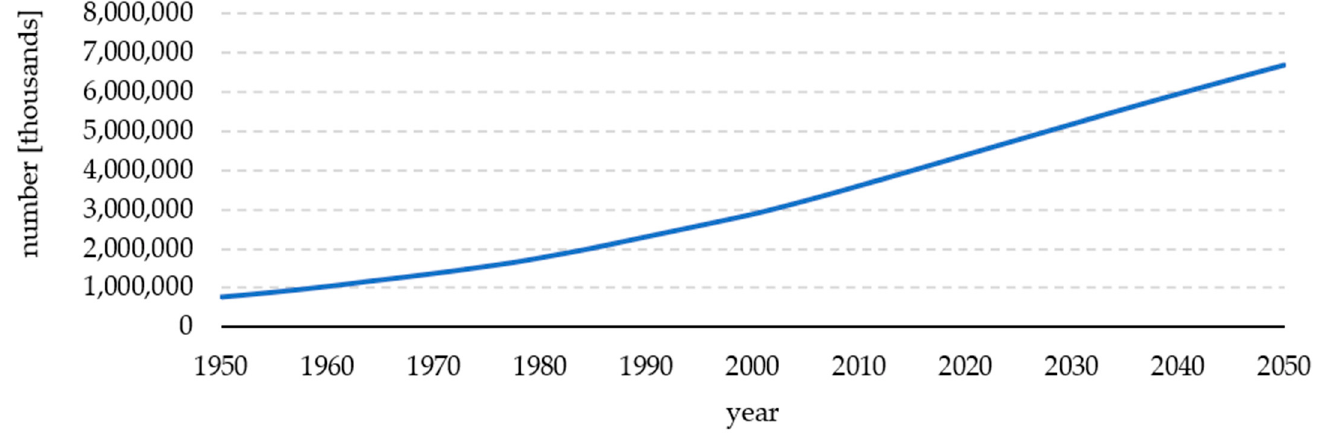
Figure 2. Predicted number of people living in cities relative to the world’s total population (own research on the basis of [1]).